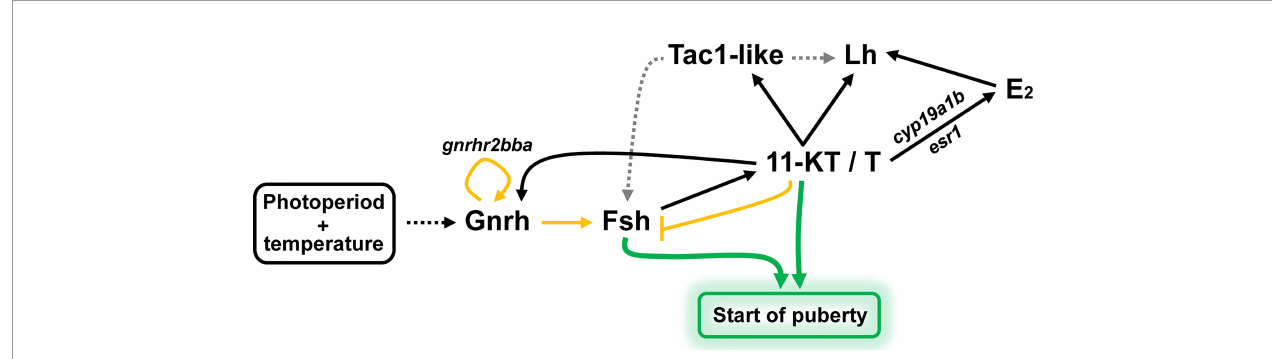
FIGURE 7 | Schematic illustration summarizing the regulation of pituitary Fsh/ fshb expression and production at the, experimentally induced, onset of puberty in male Atlantic salmon. Described effects are indicated by solid lines, while dashed lines denote no experimental evidence reported here but previously demonstrated in other studies. Yellow lines highlight effects that are potentially limited in time: in vivo response to stimulatory conditions blunts both, the stimulatory effect of Gnrh on fshb and gnrhr2bba , and the inhibitory effect of 11-KT on fshb transcript levels. Gnrh, gonadotropin-releasing hormone; Fsh, follicle-stimulating hormone; Lh, luteinizing hormone; 11-KT, 11-ketotestosterone; T, testosterone; E 2 , 17 b -estradiol; Tac1-like, protachykinin-like; gnrhr2bba , gonadotropin-releasing hormone receptor 2bba; cyp19a1b , brain aromatase; esr1 , estrogen receptor